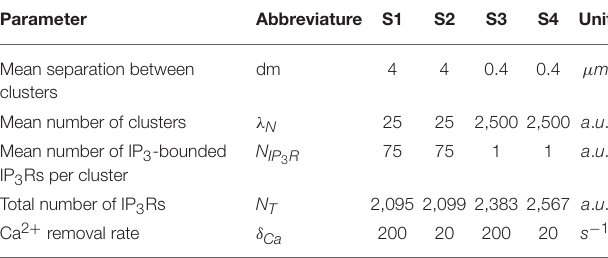
TABLE 3 | Values of the parameters used in the stochastic